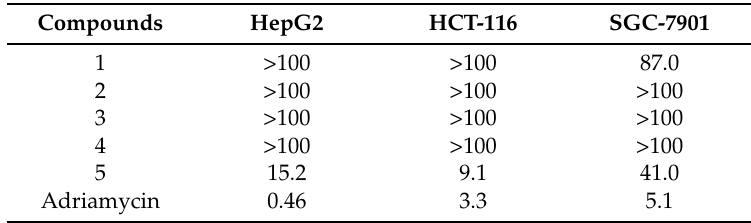
Table 4. Cytotoxicity against Cancer Cell Lines of compounds 1 – 5 (IC 50 , µ M). Compounds